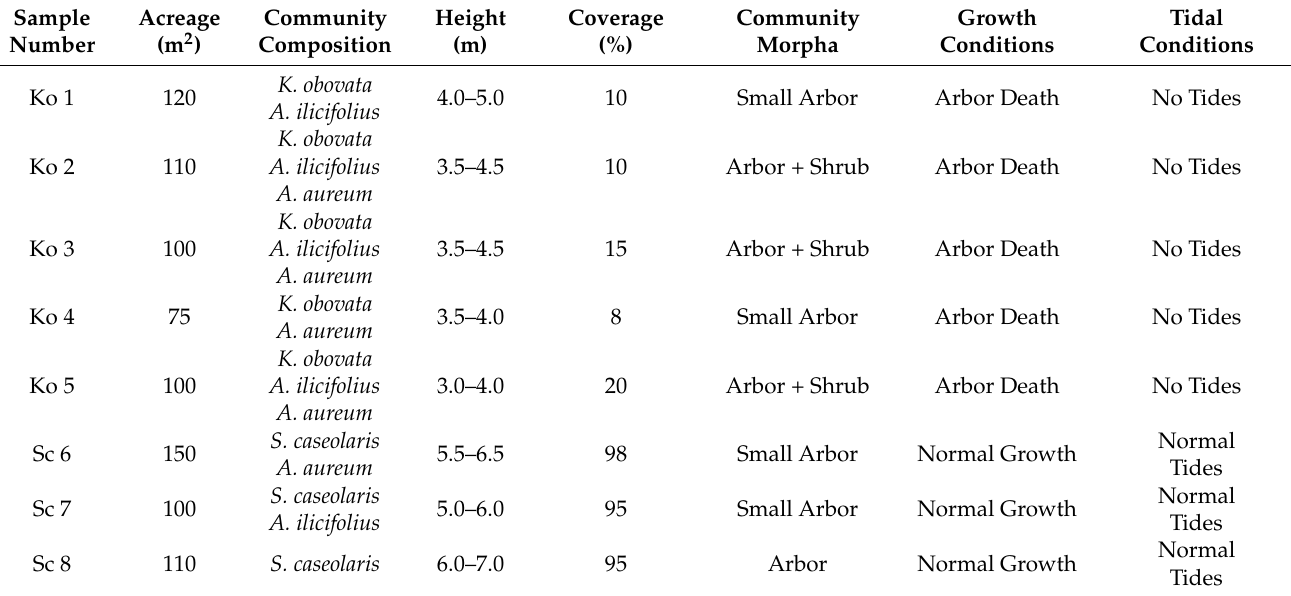
Table 1. The states of mangrove community characteristics and hydrological connectivity along the western coast of Bao’an, Shenzhen.